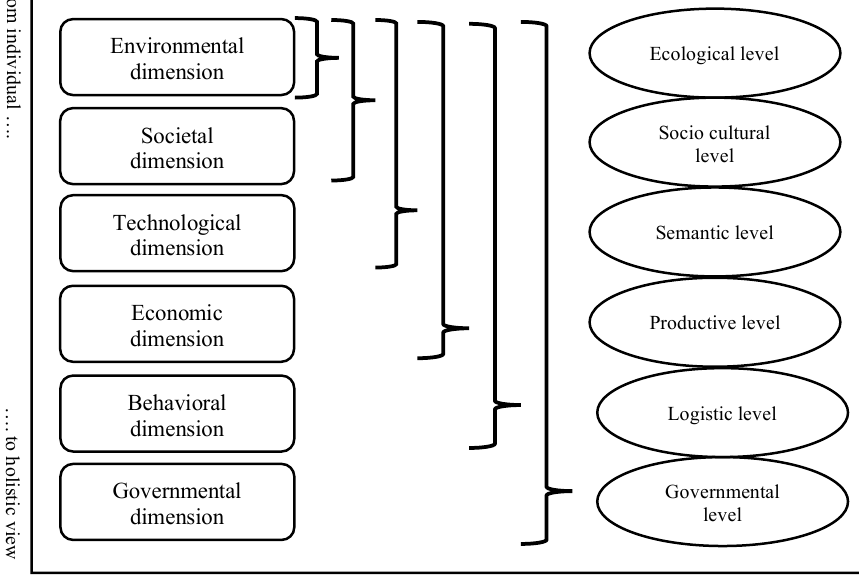
Figure 1 . A conceptual model for Cities Circular